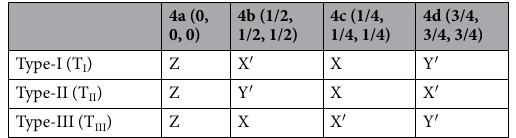
Table 1. Possible structure types of XX ′ Y ′ Z